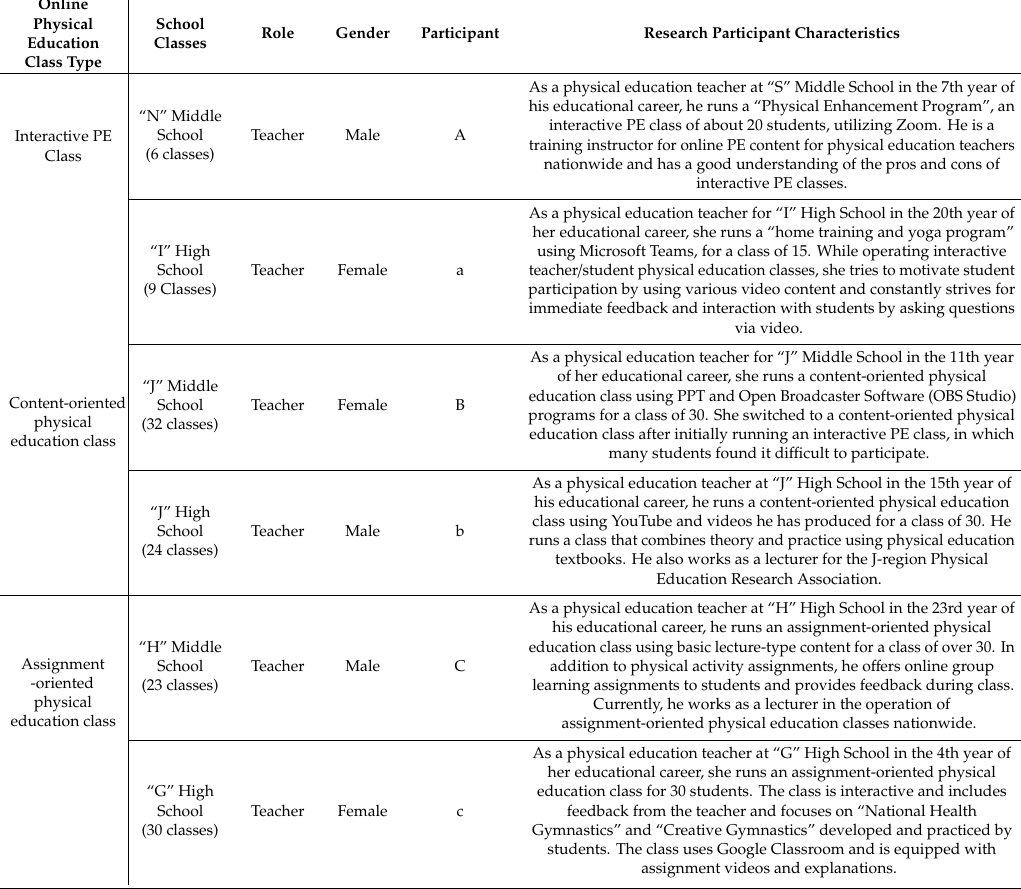
Table 1. Participant